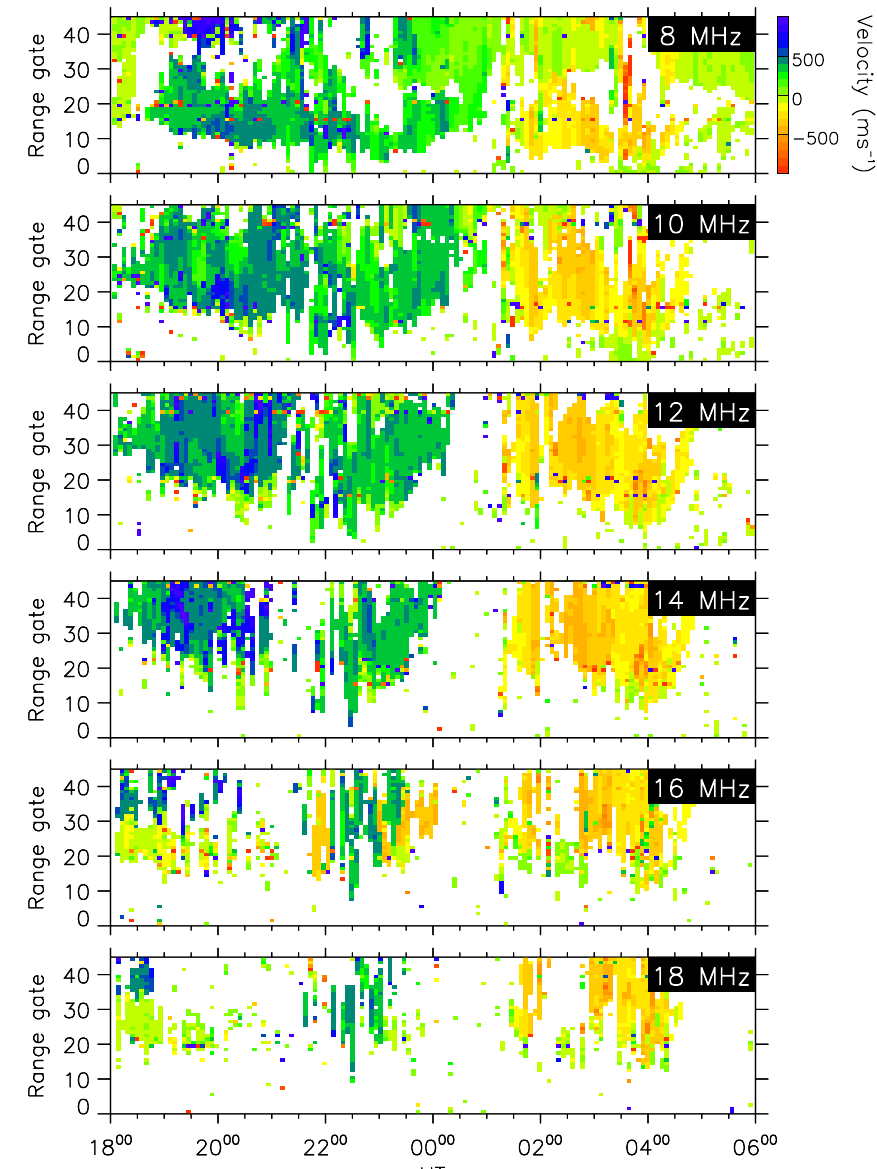
Fig. 3. Range-time-Doppler shift plots from the six frequency bands employed in the